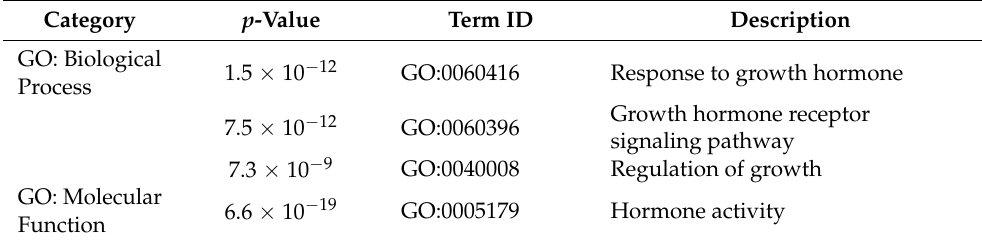
Table 13. Selected top gene term enrichments of the coexpressed genes to CSHL1 in HGCA2.0. Category p -Value Term